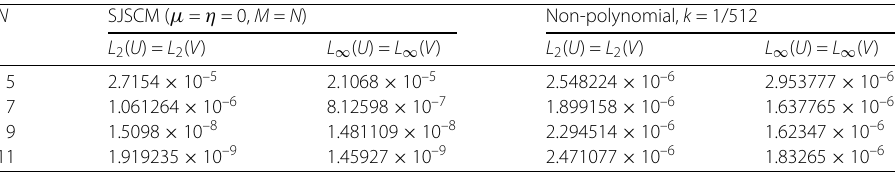
Table 11 L 2 and L ∞ error norms for u ( x , t ) = v ( x , t ) of Example 2 when 0 ≤ x ≤ 3, α 1 = α 2 = 0.2